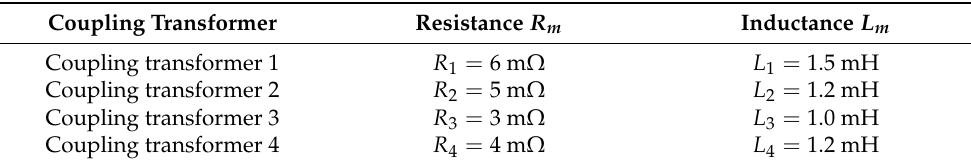
Table 1. Resistance and inductance values of the coupling transformers. Coupling Transformer Resistance R m Inductance L m Coupling transformer 1 R 1 = 6 m Ω L 1 = 1.5 mH Coupling transformer 2 R 2 = 5 m Ω Coupling transformer 3 R 3 = 3 m Ω Coupling transformer